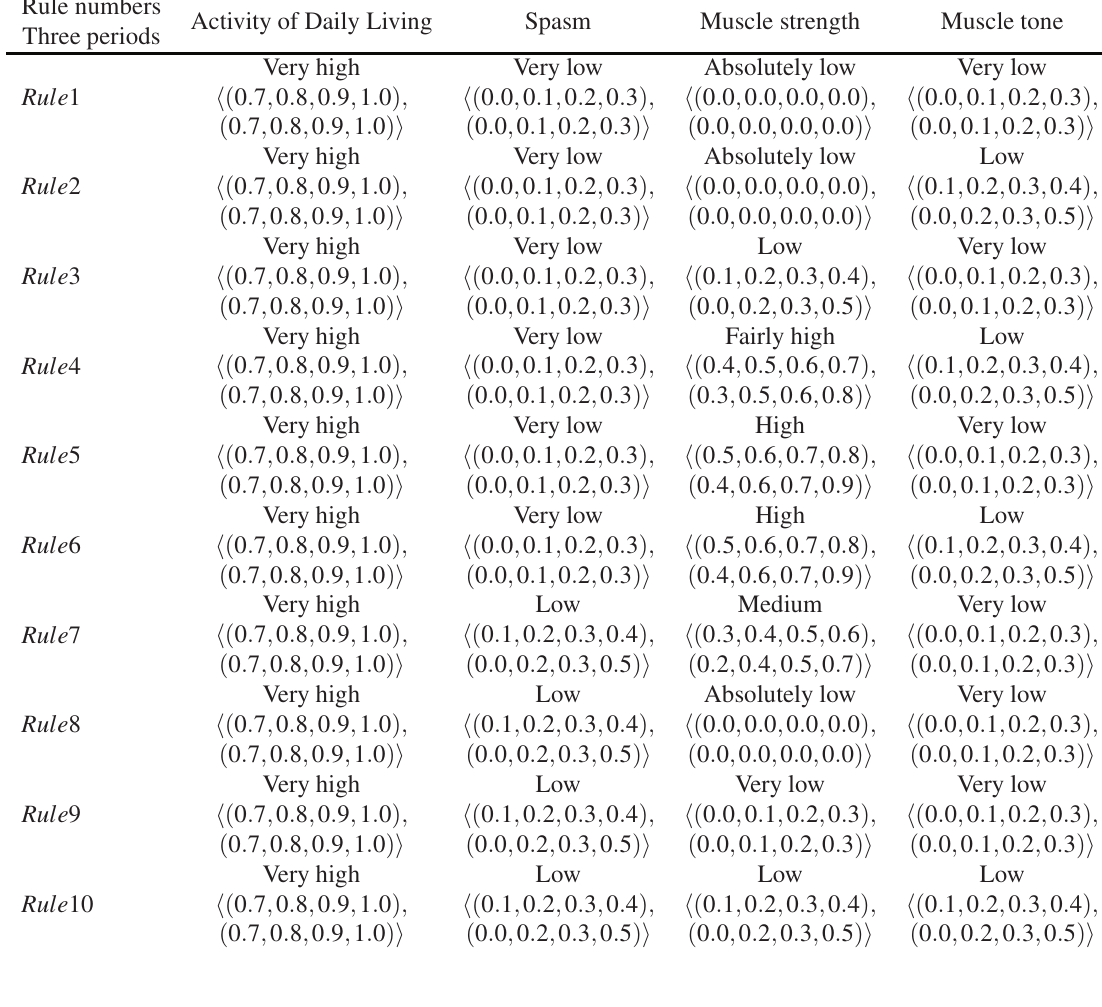
Table A.1. Three periods of stroke pathological knowledge base represented using ITFN( Rule 1 − Rule 24 for Flaccid paralysis period, Rule 25 − Rule 28 for Spastic period, Rule 29 − Rule 52 for Convalescence period